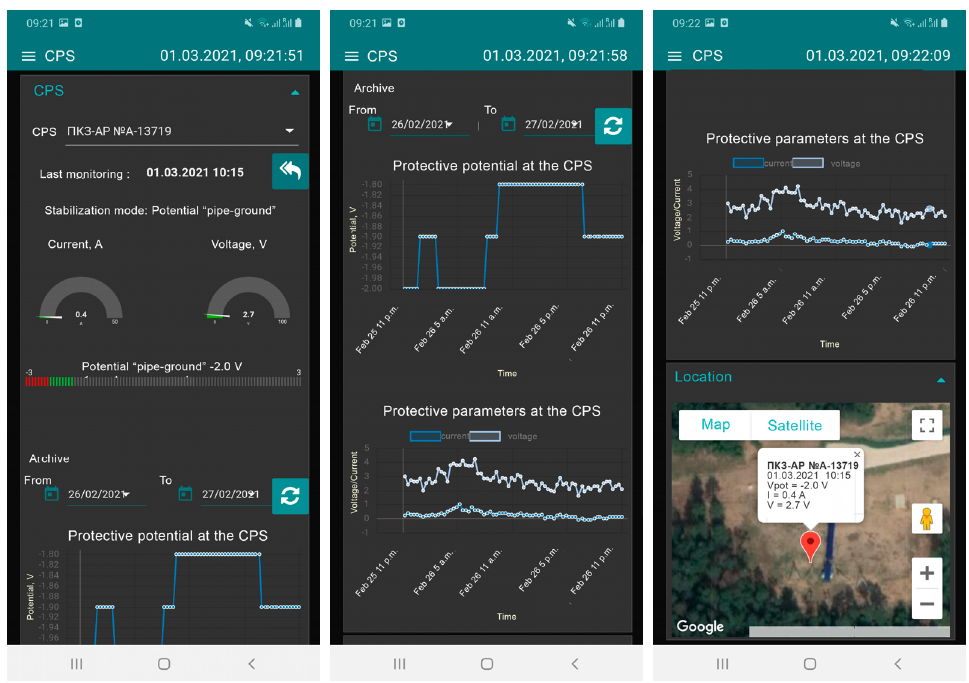
Figure 5. Dashboard with monitoring data on a mobile interface.